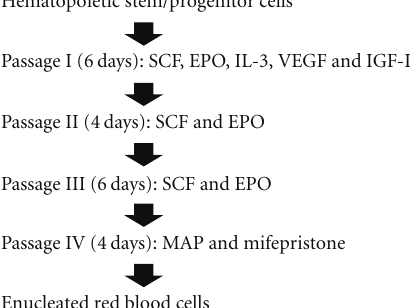
Figure 1: Culture protocol for the e ffi cient production of enu- cleated red blood cells without feeder cells from hematopoietic stem/progenitor cells. Passage I ∼ III are the steps to expand ery- throid progenitor cells. Passage IV is the step to induce enucleation of progenitor cells. SCF, stem cell factor; EPO, erythropoietin; IL- 3, interleukin-3. VEGF, vascular endothelial growth factor; IGF- II, insulin-like growth factor-II; MAP, mixture of D-mannitol, adenine, and disodium hydrogen phosphate